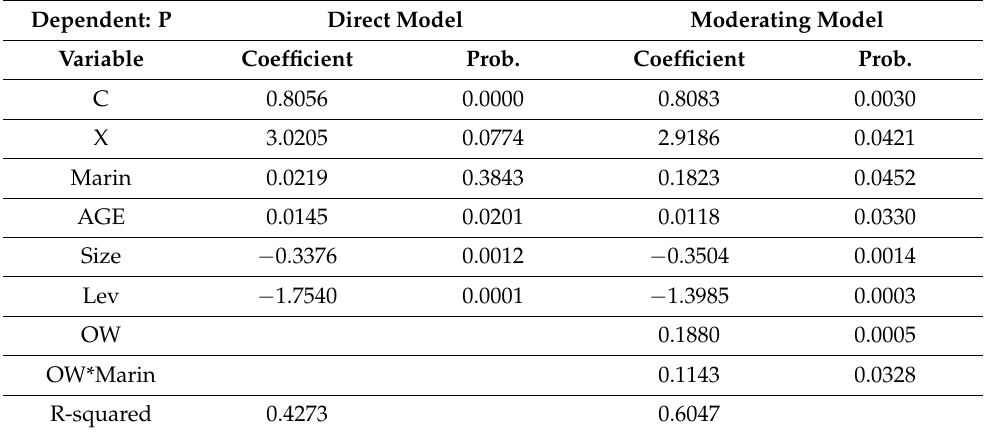
Table 6. Marketing investment and firm value: estimation